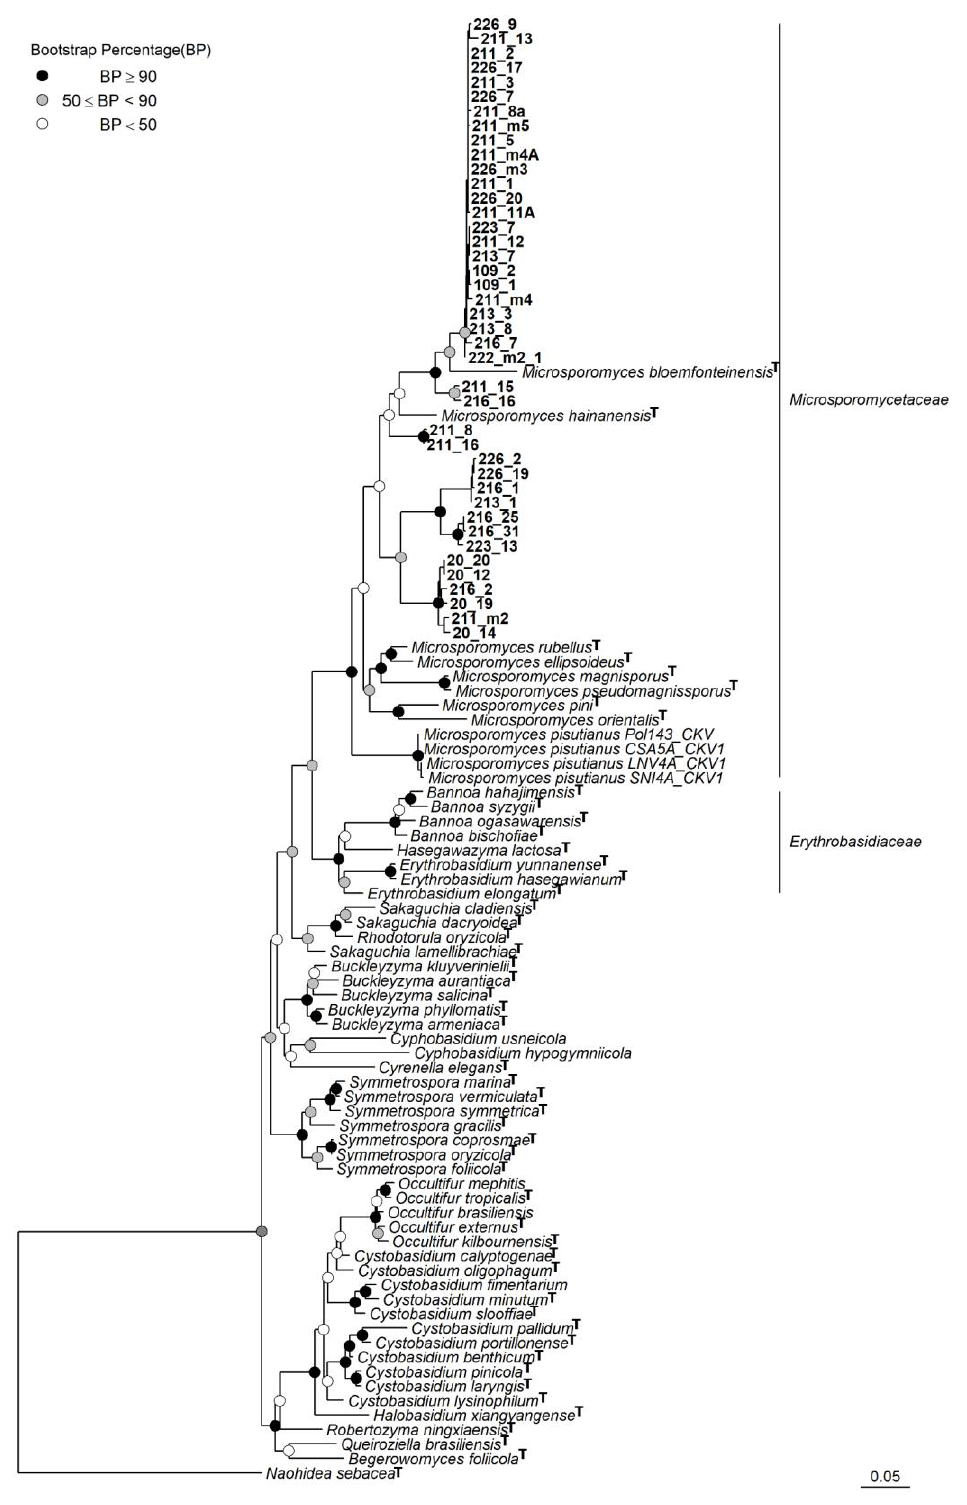
Figure 1. Phylogenetic tree of Cystobasidiomycetes obtained via the maximum likelihood analysis of the combined sequences of the LSU rDNA and ITS regions. T indicates the sequence from the holotype strain was used.